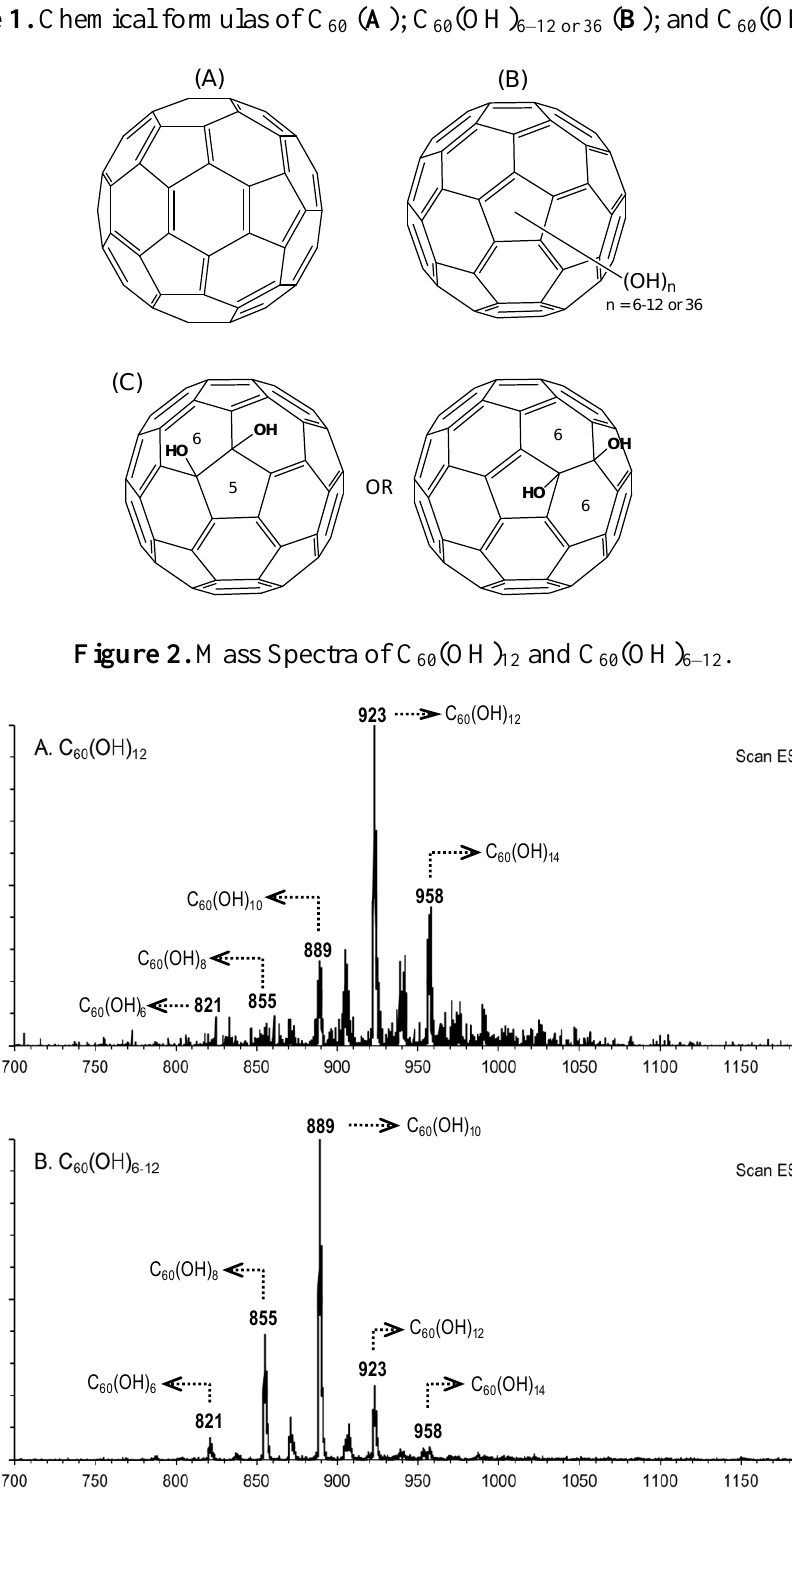
Figure 1. Chemical formulas of C